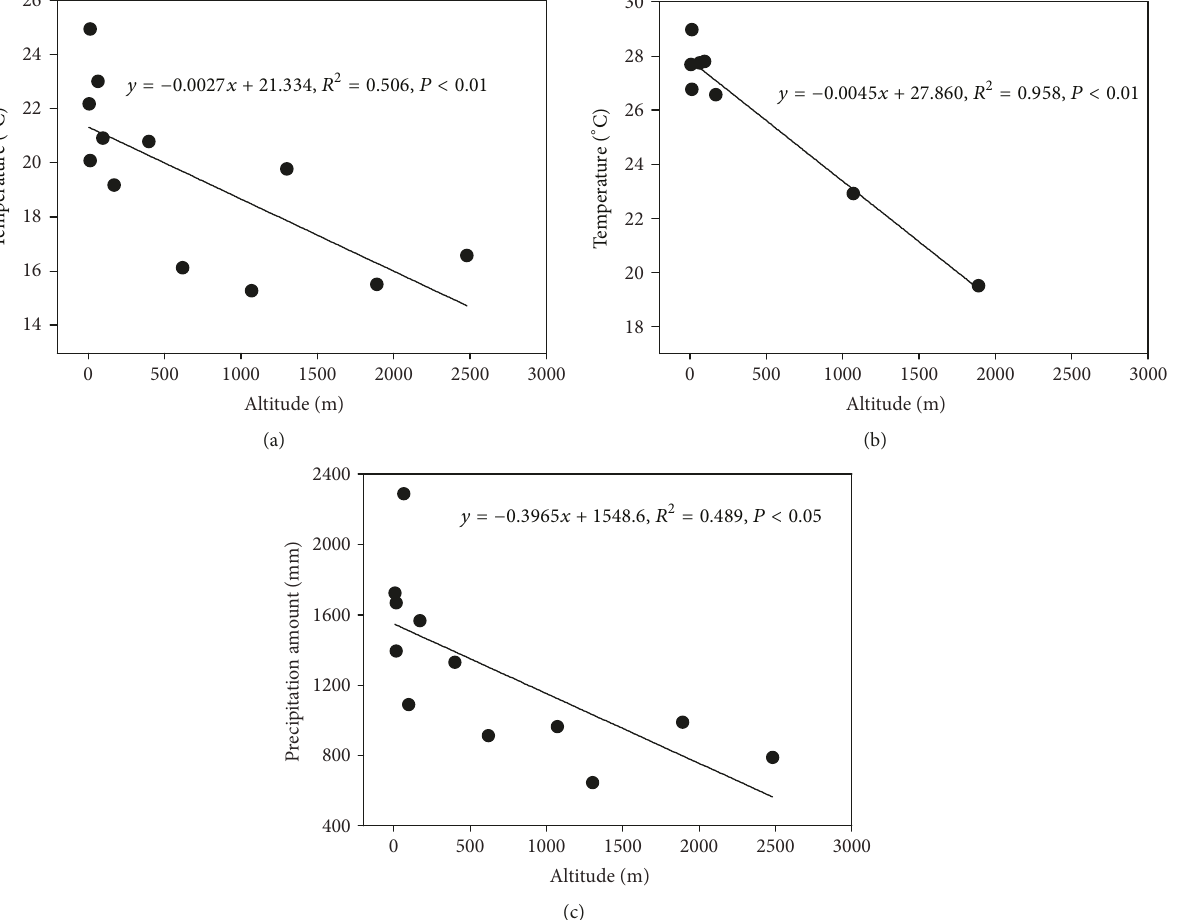
Figure 7: Correlations of mean annual temperature (a), mean summer monsoon temperature (b), and mean annual precipitation (c) for stations with